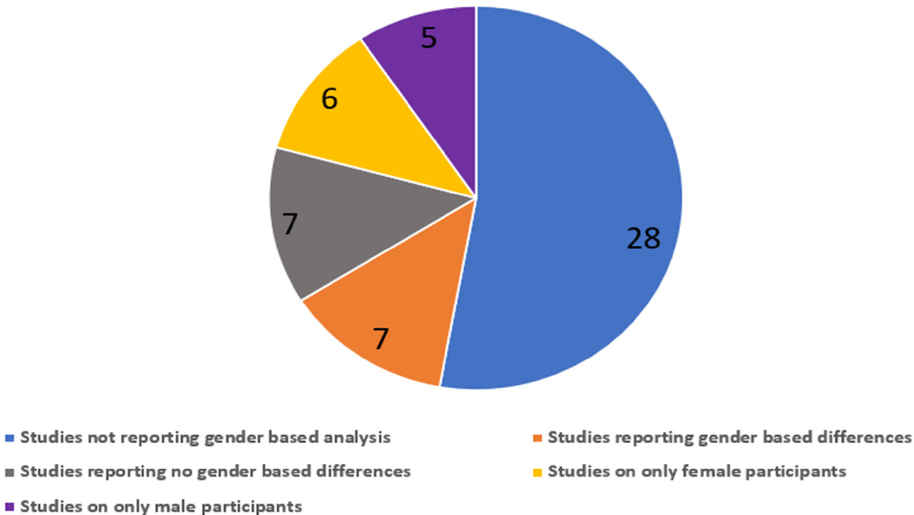
Figure 3. Gender-based reporting in original studies on air-pollution-associated cognitive impair- ment.